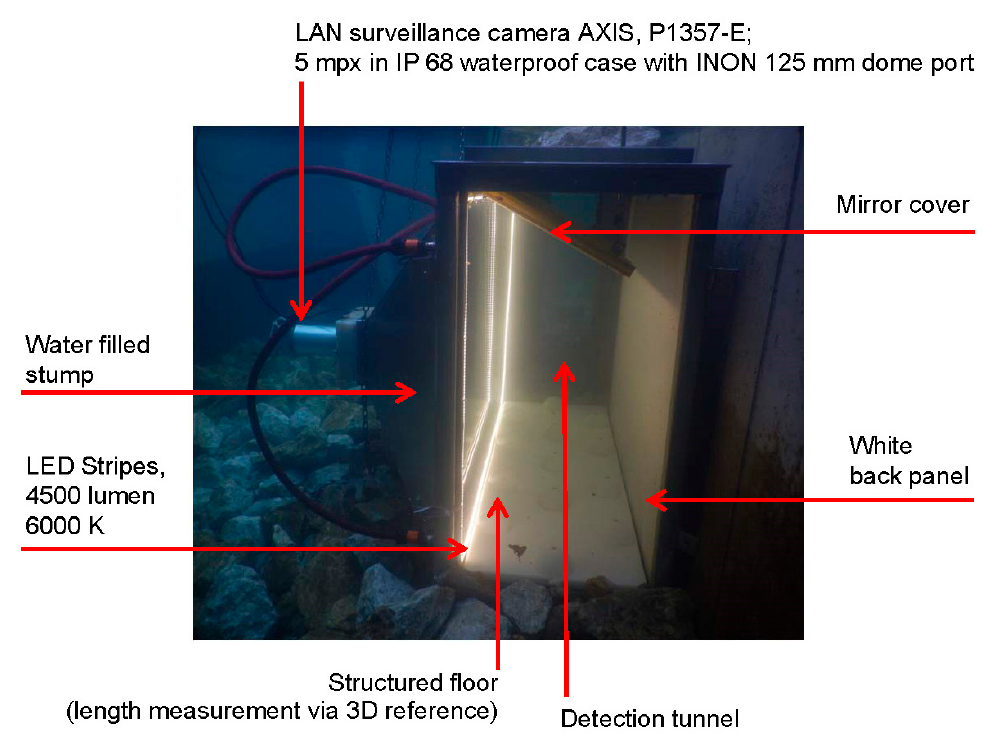
Figure 3. The FishCam, detection tunnel, structured floor, and mirror ‐ covered lid in action.